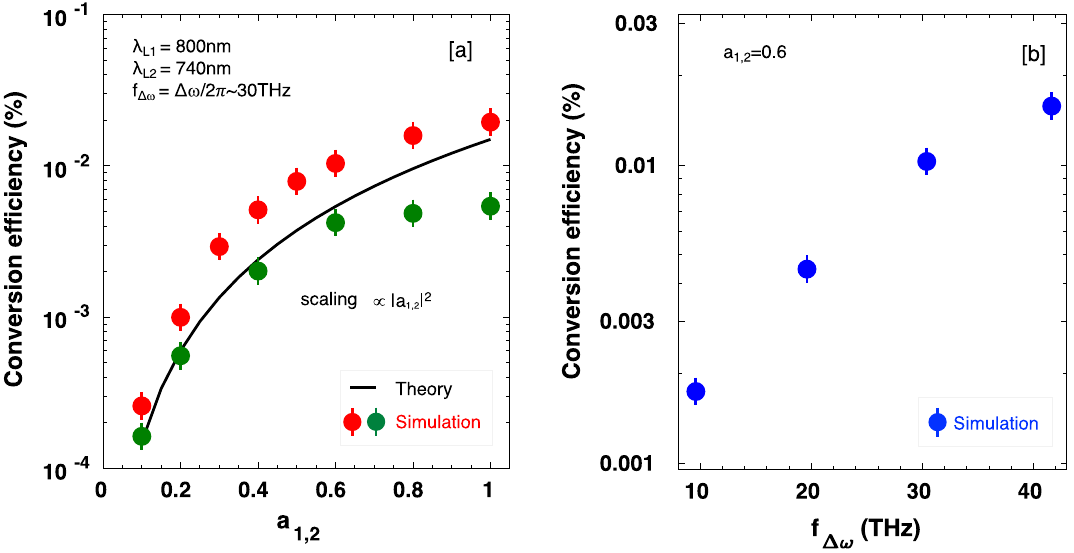
Figure 6. Efficiency of power conversion from lasers-to-THz emissions as a function of; ( a ) normalized vector potential of lasers a 1,2 , ( b ) central-frequency of THz radiation f �ω . The solid-red, -green, and -blue circles 10 µ m from the emission spot), and the solid black line is from are from simulation results (measured at ± theoretical